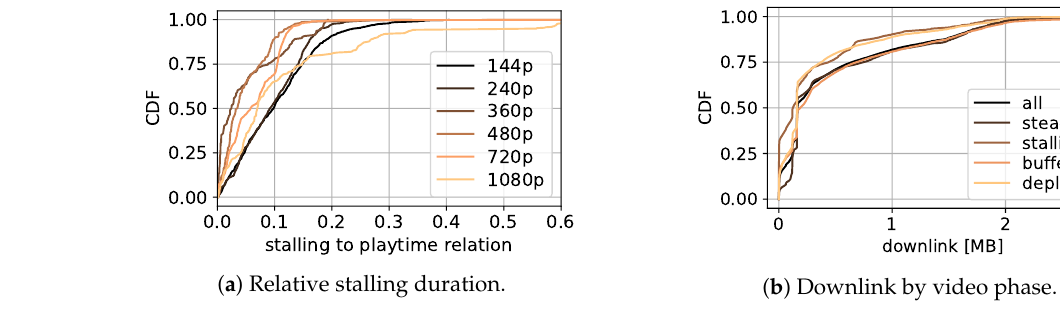
Figure A5. Dataset overview: stalling and video